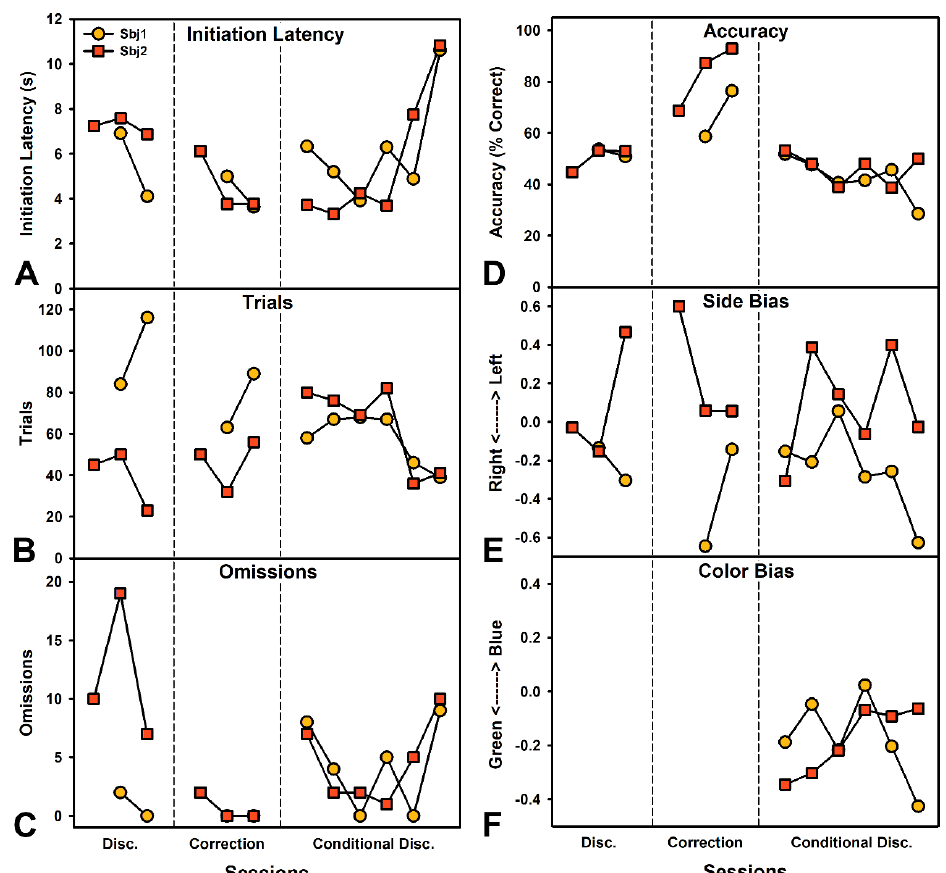
Figure 3. Performance on a Color Discrimination task for two female pigs (Experiment 2). Partitions from left to right indicate performance during an initial discrimination (yellow choices reinforced), the same discrimination but with correction trials which forces choice of the correct option after an incorrect choice, and finally a conditional discrimination where a blue or green box was shown in the middle and then two choice boxes presented and only choices of the presented color were reinforced. ( A ) Mean latency per session to initiate trials after a tone played indicating button availability. Latencies increased as performance worsened under the conditional discrimination. ( B ) Total trials completed per session. Trials remained relatively high throughout. ( C ) Total omissions per session. Omissions for one pig were large during initial performance, and then somewhat variable under the conditional discrimination. ( D ) Percent correct choices. Pigs performed poorly until the correction trials were implemented and then rapidly improved. Conditional discrimination performance was very poor. ( E ) Preference for left versus right ( − 1 to 1 scale with 0 indicating no preference). Pigs exhibited moderate side biases throughout testing. ( F ) Preference for green versus blue color ( − 1 to 1 scale with 0 indicating no preference). Pigs showed a strong preference toward green, which may be more similar to the previously reinforced